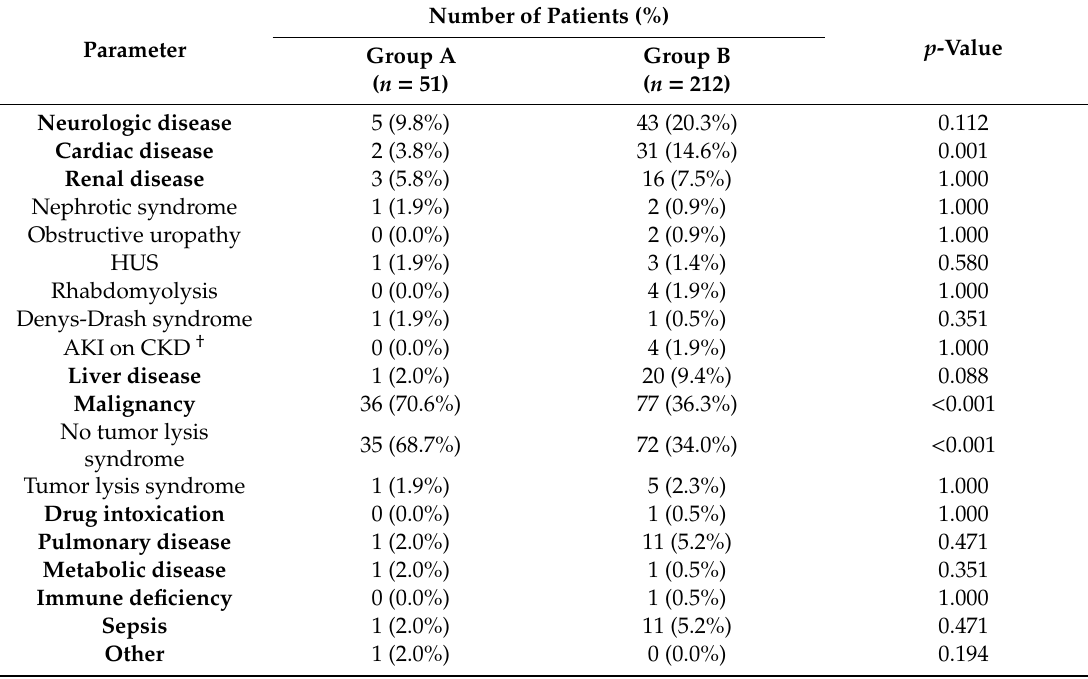
Table 2. Underlying diseases of patients receiving